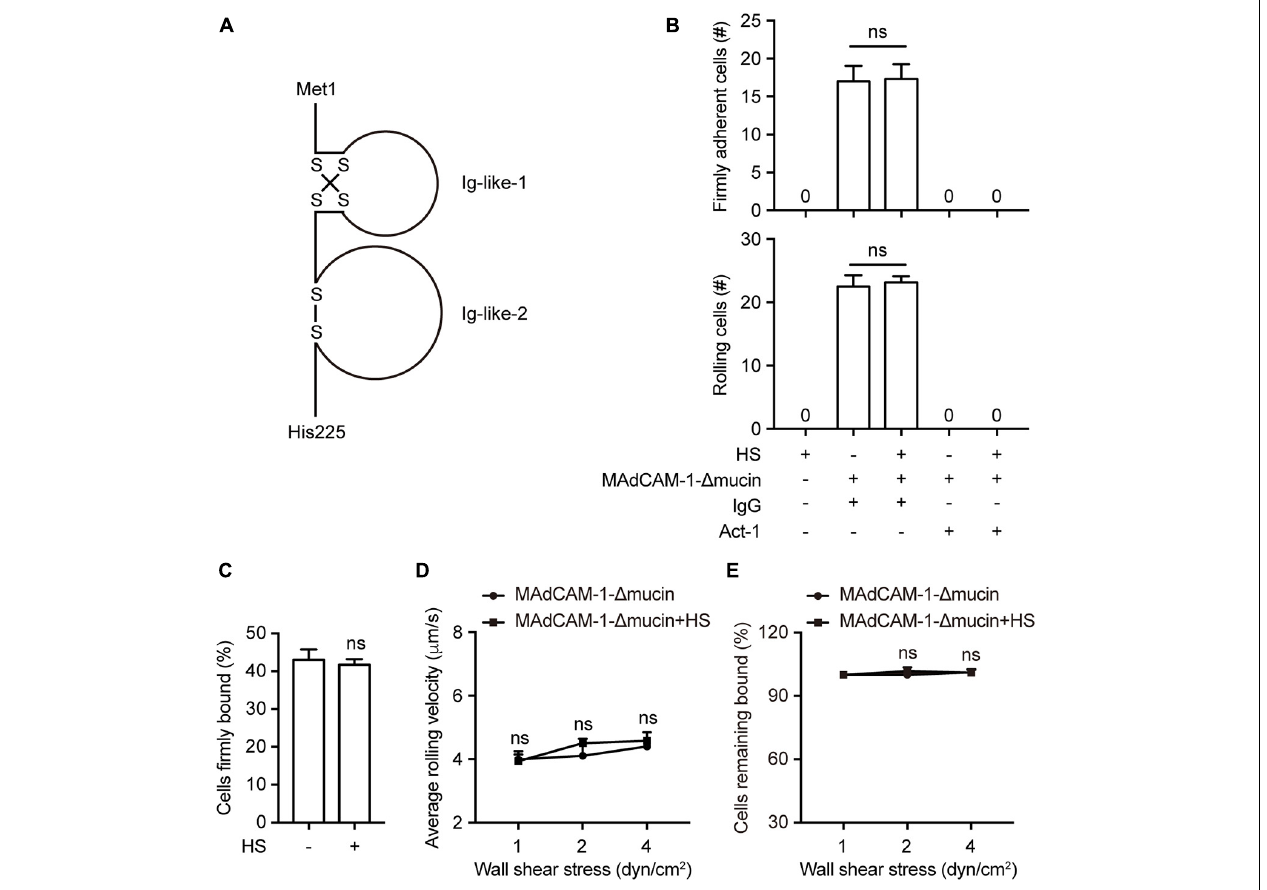
FIGURE 2 | HS-enhanced integrin α 4 β 7-mediated cell adhesion is dependent on mucin-like domain of MAdCAM-1. (A) Schematic diagram of the structure of the extracellular domain of MAdCAM-1 with a deletion of mucin-like domain. (B–E) Adhesive behaviors of 293T- α 4 β 7 cells on immobilized HS (100 µ g/ml) or MAdCAM-1- (cid:49) mucin (100 µ g/ml) substrates in 1 mM Ca 2 + /Mg 2 + . The number of rolling and firmly adherent 293T- α 4 β 7 cells was measured at a wall shear stress of 1 dyn/cm 2 . Cells were pre-treated with murine IgG (10 µ g/ml) or α 4 β 7 blocking antibody Act-1 (10 µ g/ml) for 10 min at 37 ◦ C (B) . Percentage of cells firmly bound to ligand at a wall shear stress of 1 dyn/cm 2 (C) . Average rolling velocity of 293T- α 4 β 7 cells that adhered to MAdCAM-1- (cid:49) mucin substrates at indicated wall shear stresses (D) . Resistance of 293T- α 4 β 7 cells to detachment at increasing wall shear stresses (E) . One representative result of three independent experiments is shown in (B–E) . Data represent the mean ± SEM ( n ≥ 3) in (B–E) . ns: not significant (Student’s t